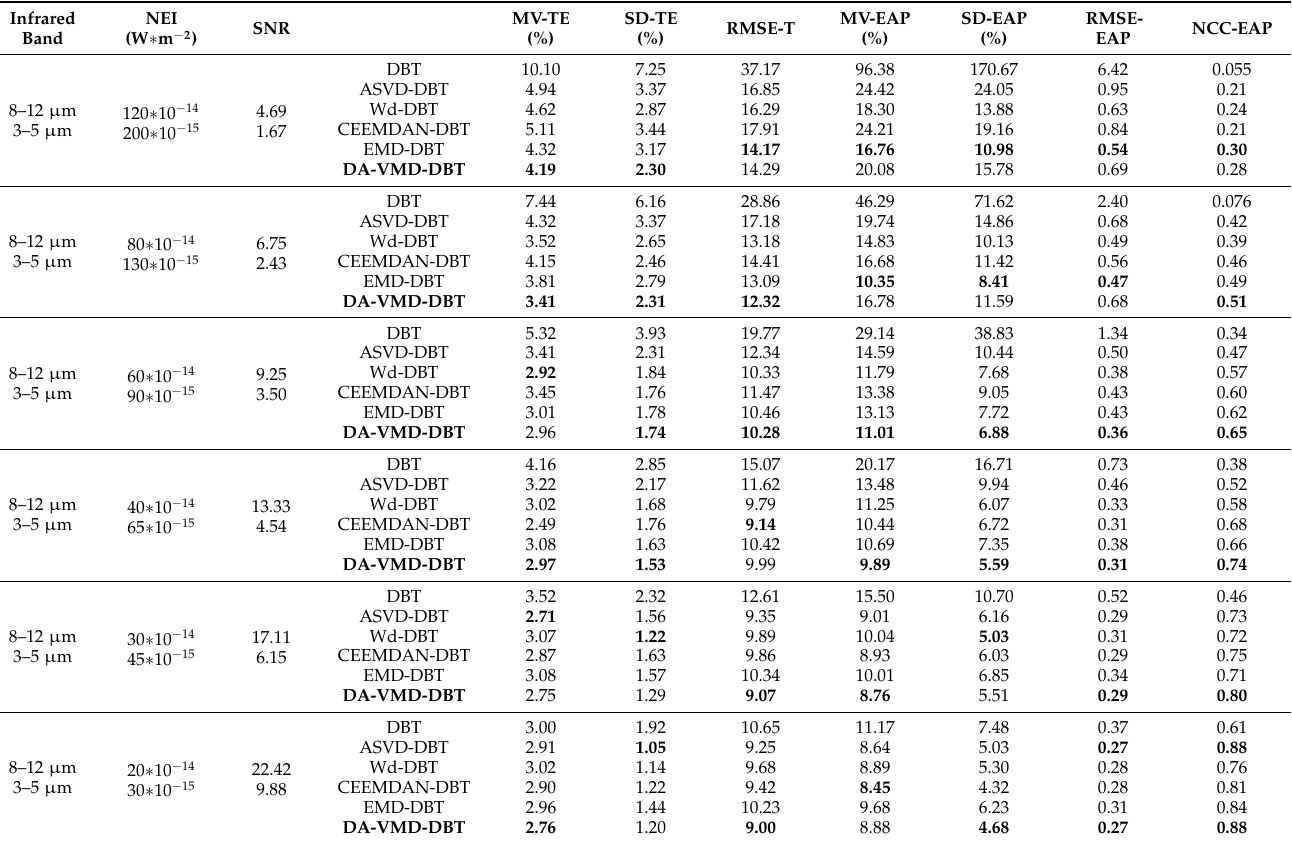
Table 8. The results of evaluation indexes of the feature extraction of simulated radiation signal (8–12/3–5 µ